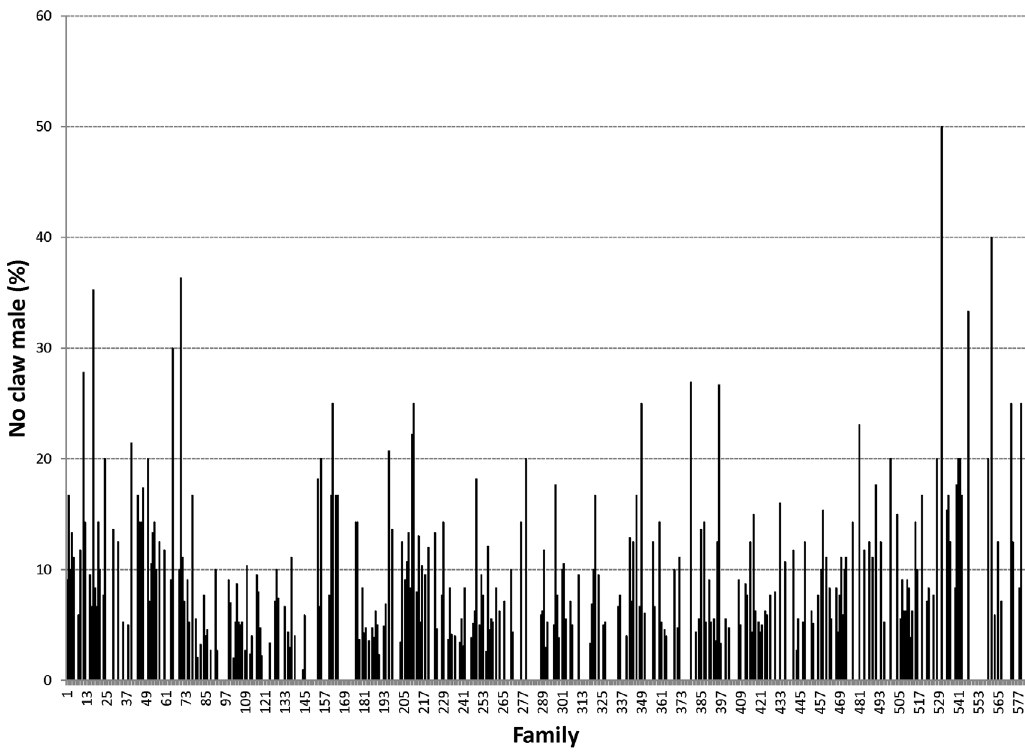
Figure 5. No claw male.